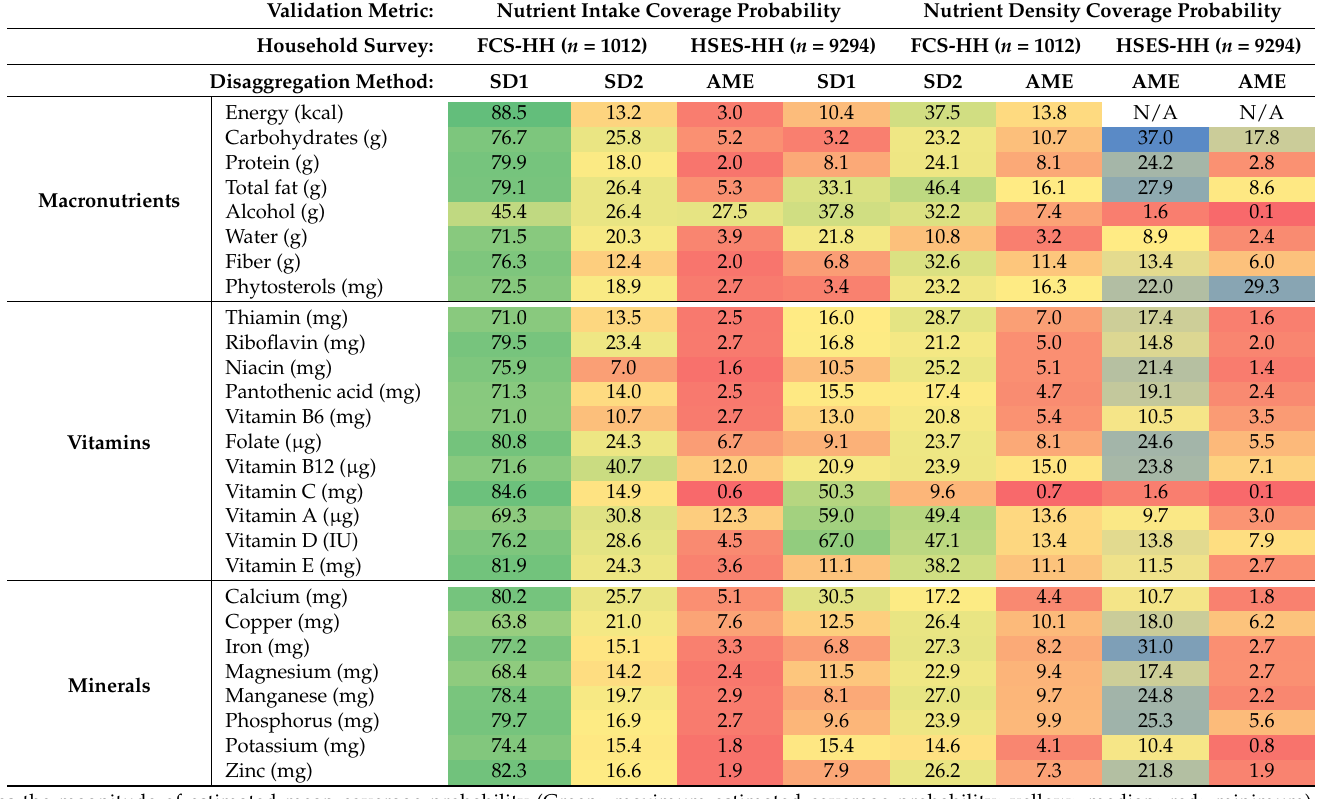
Table 3. Coverage probability of household disaggregation methods across 14 age-sex groups (mean % of observed dietary nutrient intakes or intake densities (per 100 kcal) lying within 95% confidence interval of corresponding disaggregated household consumption estimate) (Aims 2 and